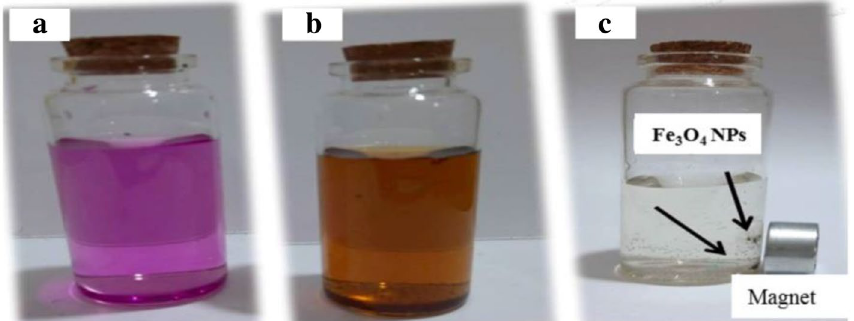
Figure 4. Color solution consists of DDW + KMnO 4 before ablation (crimson black) in ( a ), color of Fe 3 O 4 NPs colloidal solution after iron-plate ablation at a laser fluence of 28 J/cm 2 , in which the color is indicated in ( b ).